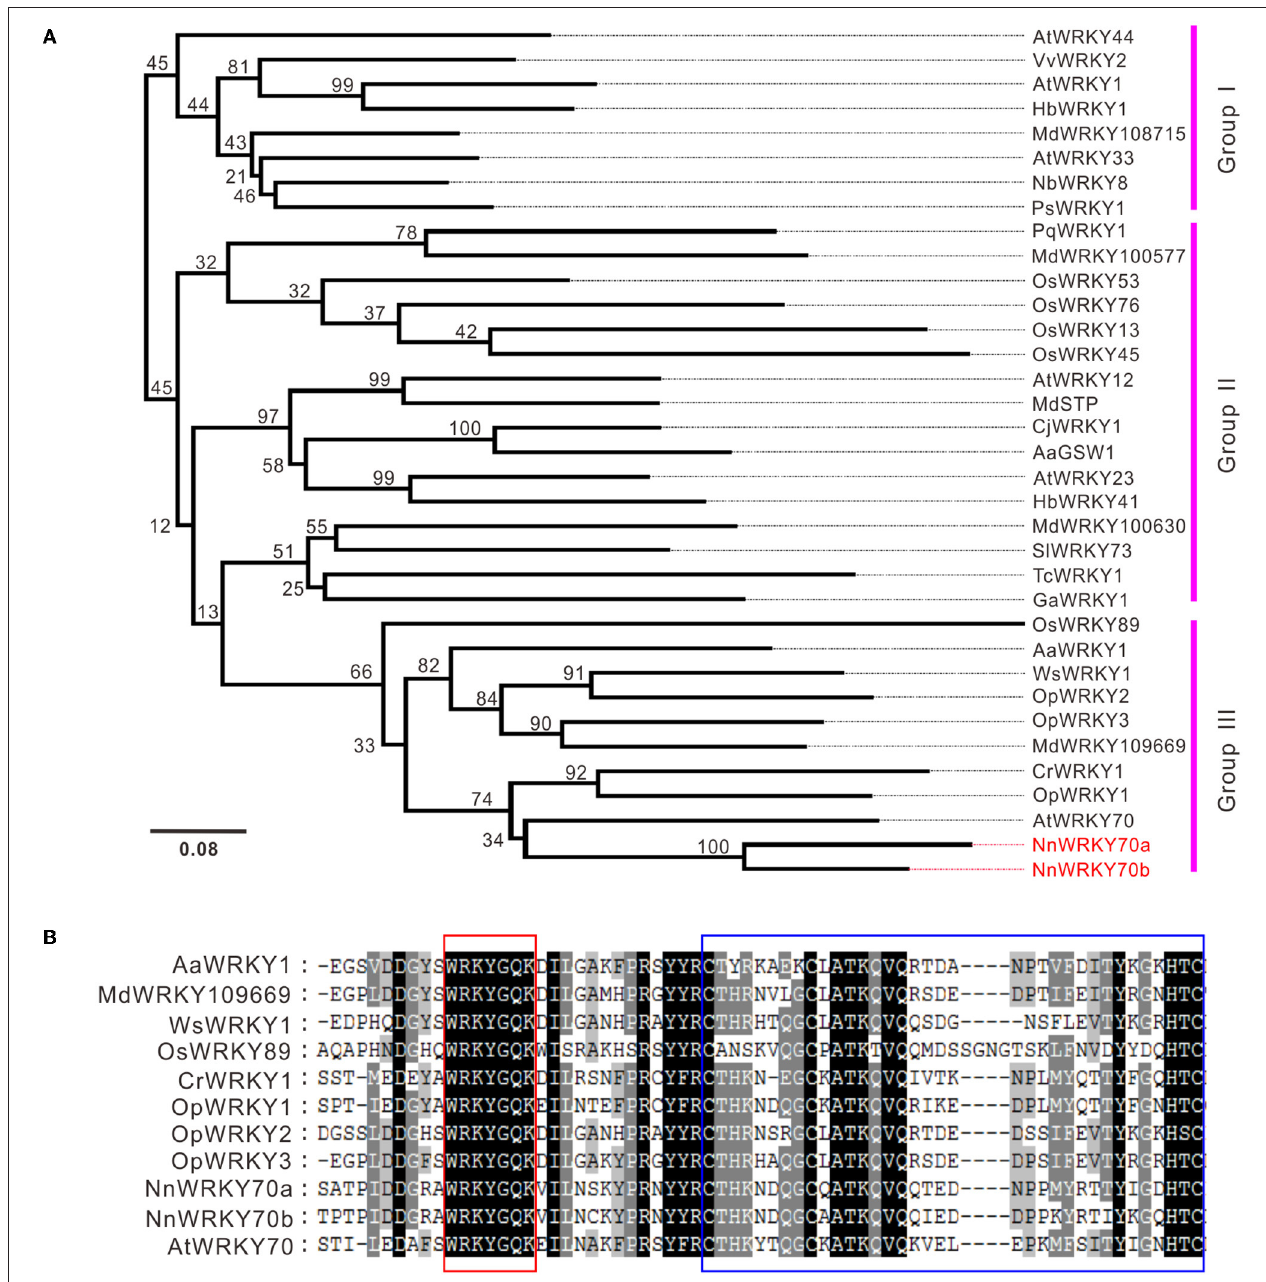
FIGURE 2 | Nucleotide and amino acid sequence characteristics of lotus WRKY70s. (A) Phylogenetic analysis of NnWRKY70a and NnWRKY70b with other WRKYs involved in the biosynthesis of plant secondary metabolites. Protein names, species, and GenBank accession numbers are listed in Supplementary Table S2 . (B) Protein sequence alignment of the selected group III WRKY members. Conserved WRKY and zinc-finger domains are highlighted in red and blue boxes,